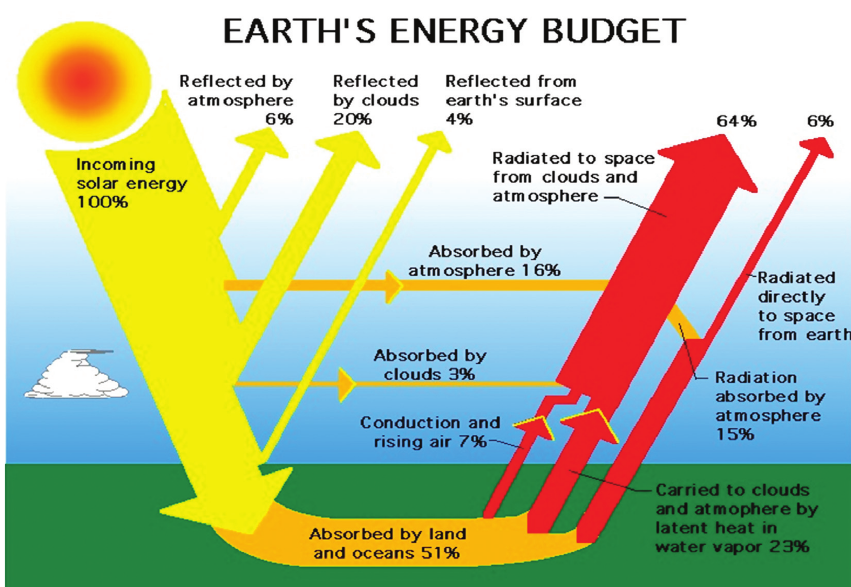
Figure 1: Model of economic energy (action energy) (https://ag.tennessee.edu/solar/Pages/What%20Is%20Solar%20Energy/Earth-Energy-